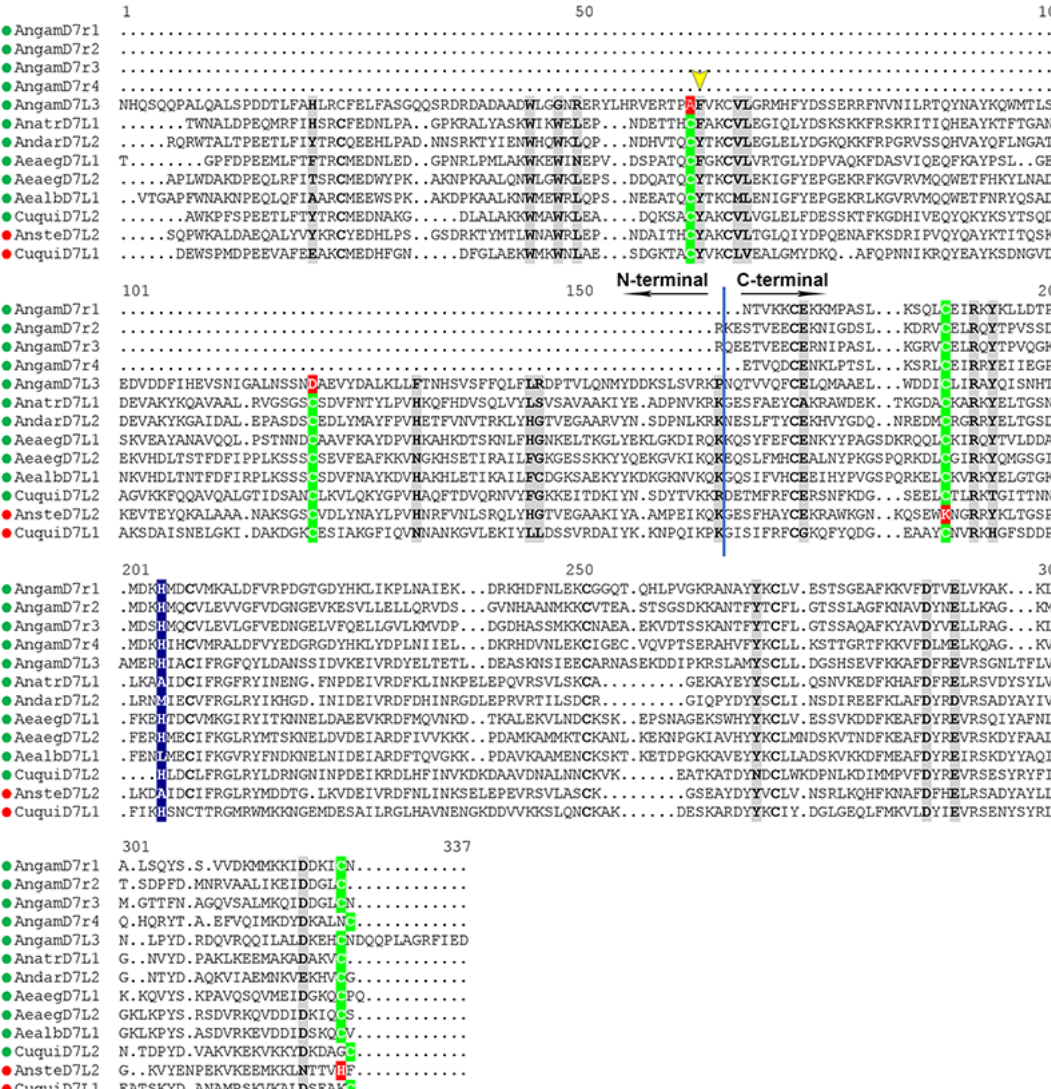
Figure 4. Alignment of D7 proteins characterized so far in different species of mosquitoes whose ligands were identified experimentally — Sequence comparison of some short (D7S or D7r) and long (D7L) forms of D7 characterized so far. Circles before each species name represent the ability of short forms and long forms C-terminal OBP like domain to bind biogenic amines (in this generalization, serotonin); squares represent the ability of long forms N-terminal domain to bind eicosanoids (cysteinyl leukotrienes). The filling color of the symbol represent whether they bind (green) or not (red) the respective ligand. N and C-terminal domains are separated by a blue line and indicated in the figure. Residues lining the binding pockets with relevance to the ligand-binding interactions as commented in the text are in grey boxes. Cysteines involved in disulfide bonds are in bold, and the ones in key positions, are highlighted in green boxes. The absence of these in some members (red box in the position) instead of green is one of the factors that might have led to loss of function, as is the case for AnSt-D7L1 (here named as An. stephensi D7L2) C-terminal that does not bind biogenic amines. In some biogenic amines binding D7s, a histidine (position highlighted in a blue box) can form a hydrogen bond with the 5-hydroxyl of serotonin further stabilizing the ligand, this is not crucial, since members having an alanine and a methionine in this position were shown to bind too, in a way that is independent of this interaction [29]. In eicosanoid binding long forms, when tyrosine is present instead of a phenyl-alanine in the position indicated by a yellow arrow head the proteins gained the capacity to bind TXA 2 in addition to cysteinyl leukotrienes.